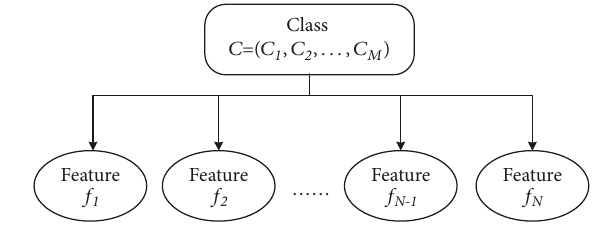
Figure 2: Basic structure of the NBC.